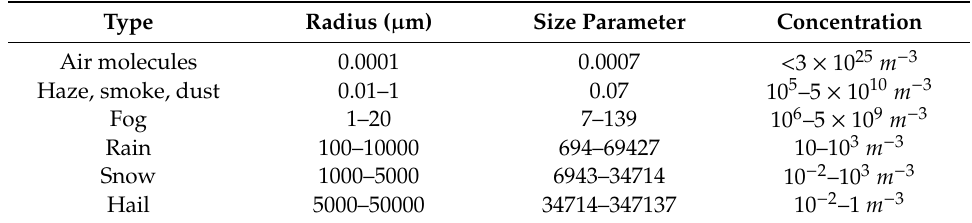
Table 1. Typical atmospheric scattering particles with their average size parameter for a wavelength from 905 nm and concentration